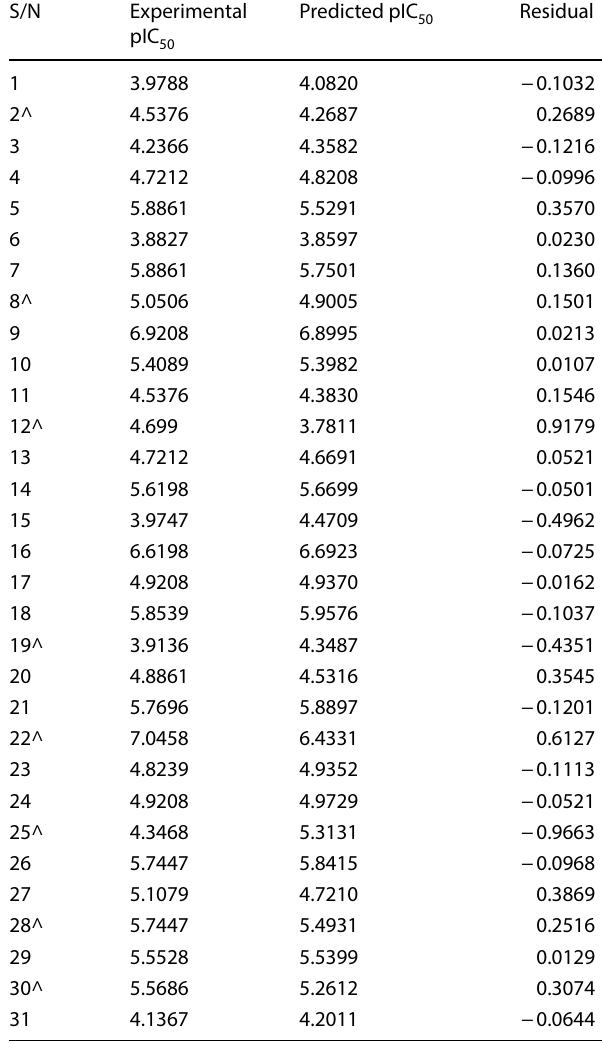
Table 2 Comparison of experimental, predicted and residual of the data